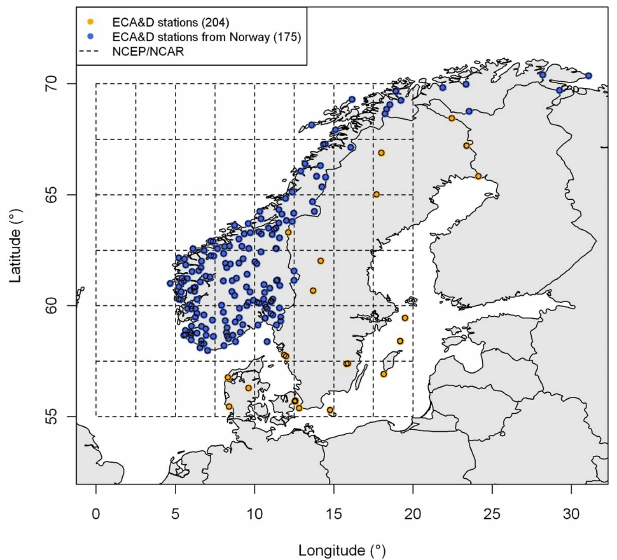
Figure 2. Precipitation stations and grid of geopotential heights used to build the WT classifications for Norway.